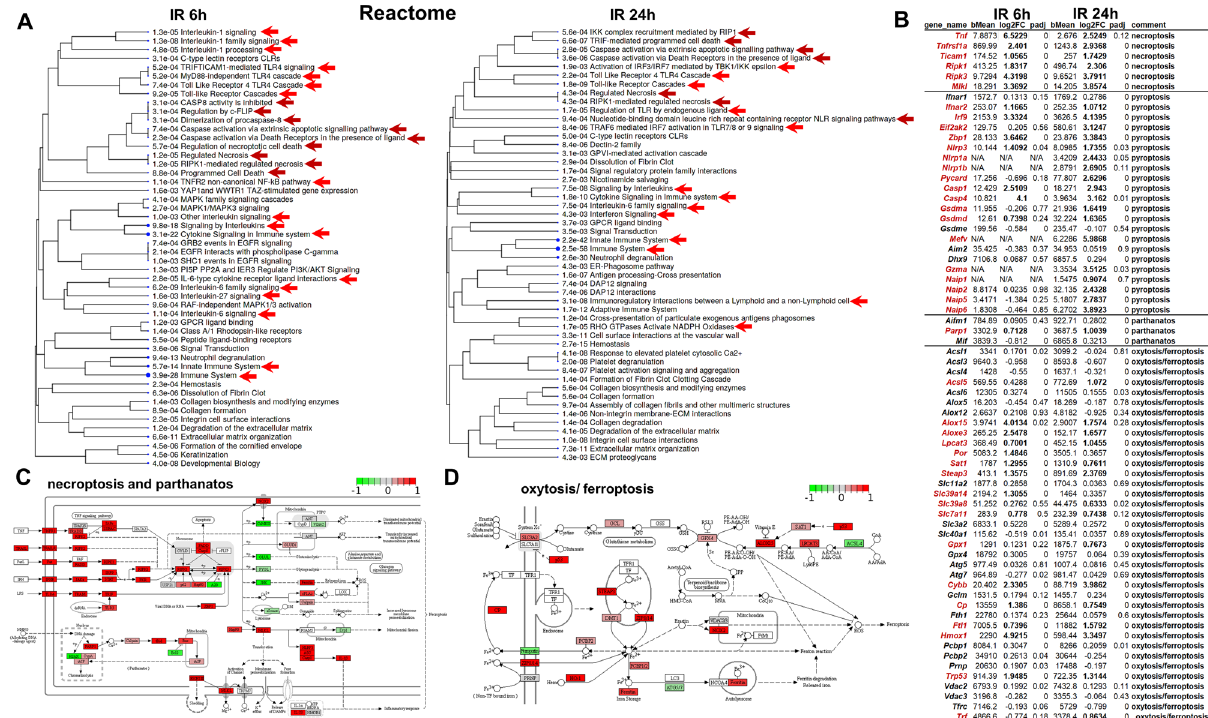
Figure 4. Multiple types of programmed necrosis are active simultaneously in the IR retina. ( A ) The results of the pathway analysis revealed that many genes with increased expression in the ischemic retina are involved in programmed (regulated) necrosis (red arrows indicate pro-inflammatory signaling cascades, dark red arrows indicate signaling cascades involved in programmed necrosis). ( B ) The expression of many genes regulating necroptosis, pyroptosis, oxytosis/ferroptosis, and parthanatos is significantly increased in the ischemic retina 6 and 24 h after reperfusion. We highlighted in dark red those genes whose expression was significantly increased (two-fold or more) in IR retinas. ( C , D ) The representative KEGG pathway maps show increased expression of necroptosis, oxytosis/ferroptosis, and parthanatos genes in the IR retina. The red box corresponds to increased gene expression in the ischemic retina, the green box corresponds to reduced gene expression in the ischemic